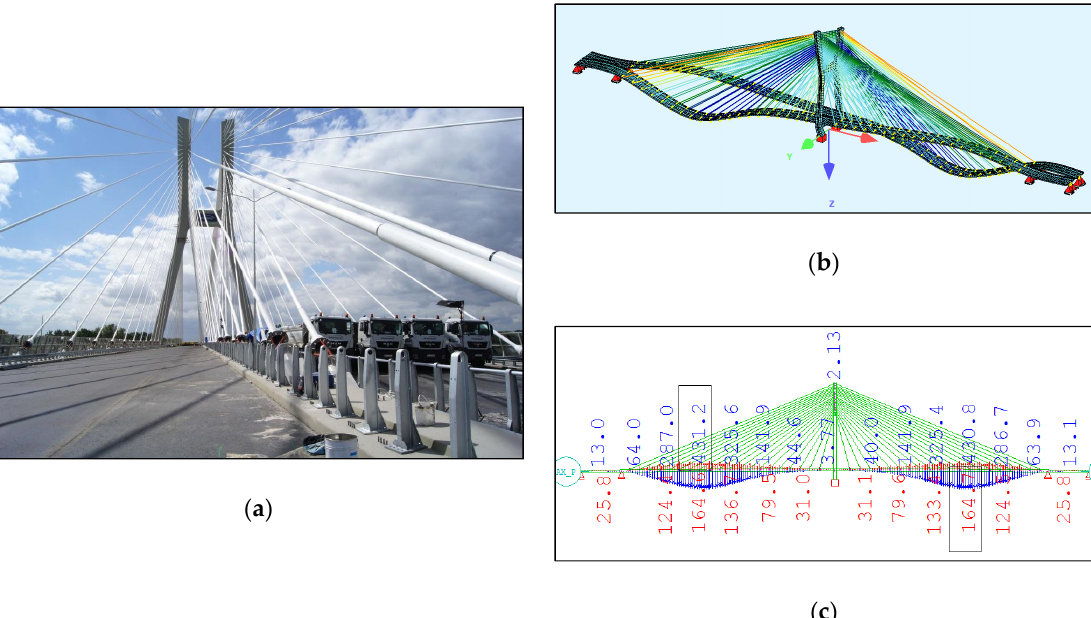
Figure 5. ( a ) The bridge during loading test [10]; ( b ) FEM model loaded; ( c ) corresponding loading deck nodes displacements in mm.